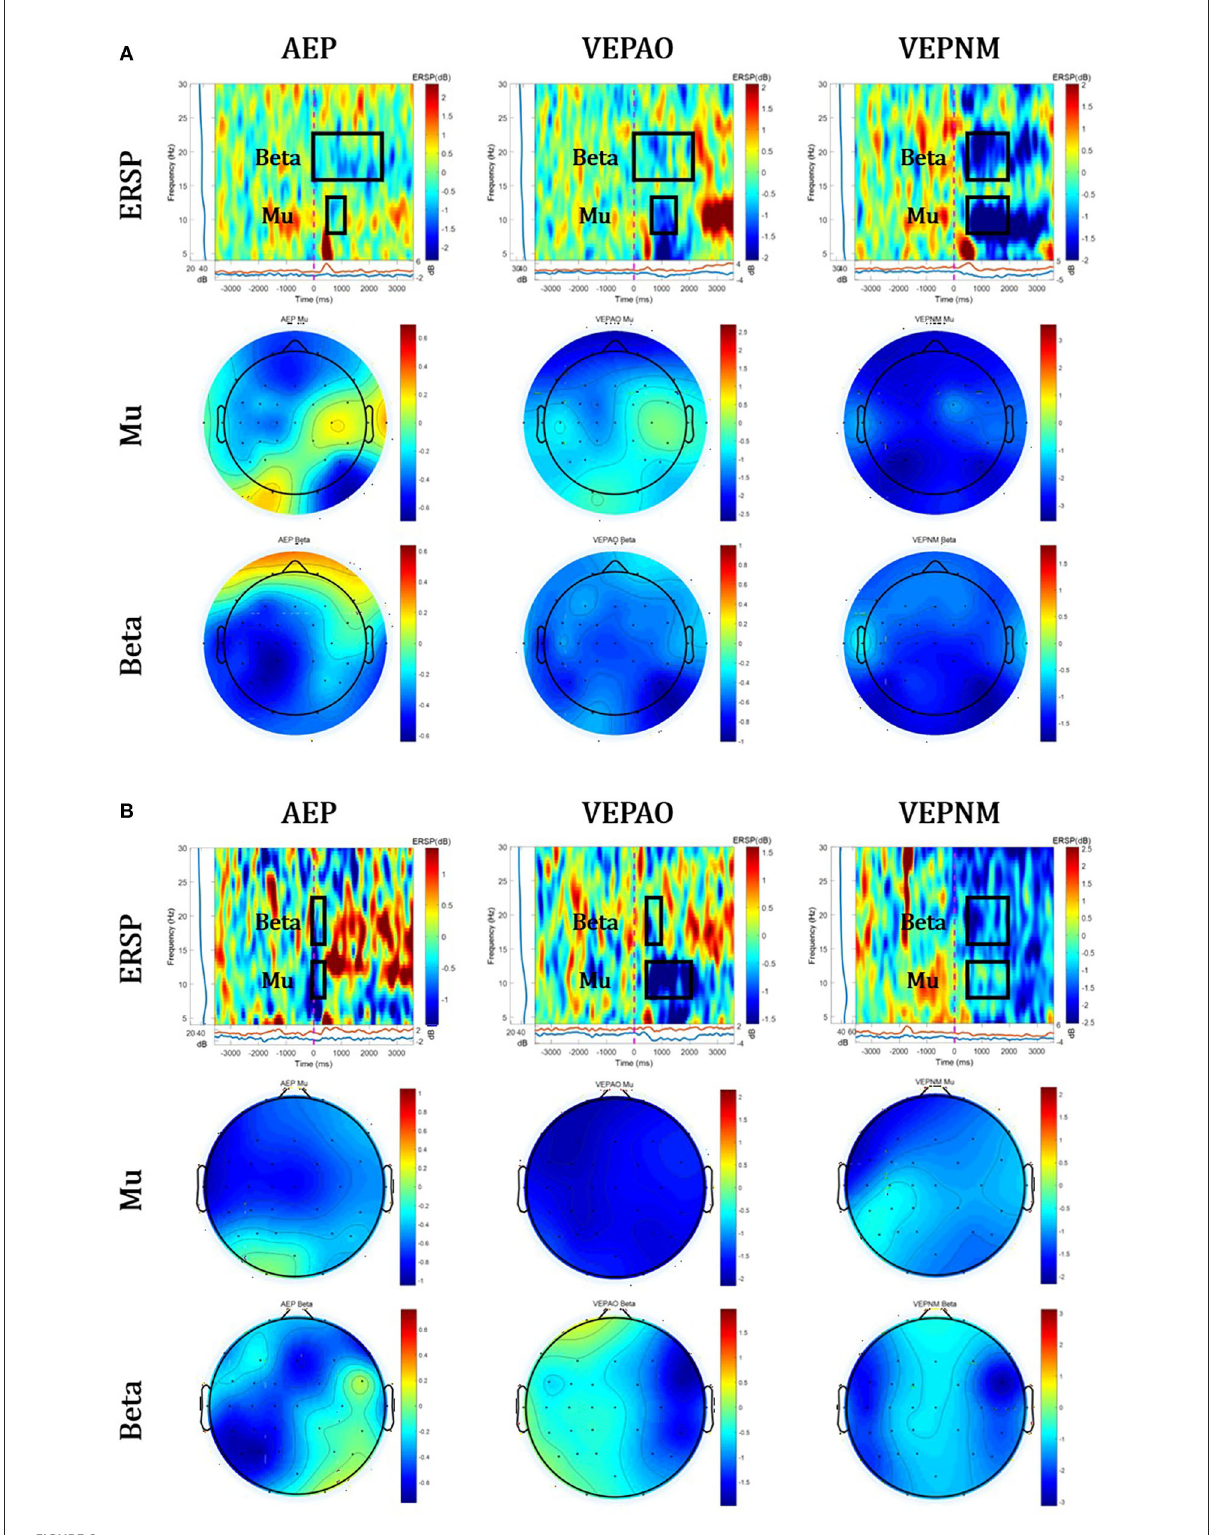
FIGURE6 Group analysis of event-related spectral perturbation (ERSP) and its topographical map of Mu and Beta ERD. The red circles represent the average source area of EEG contaminations. (A) The healthy group and (B) stroke patient group (VEPAO: VEP with action observation; VEPNM: non–motor-related